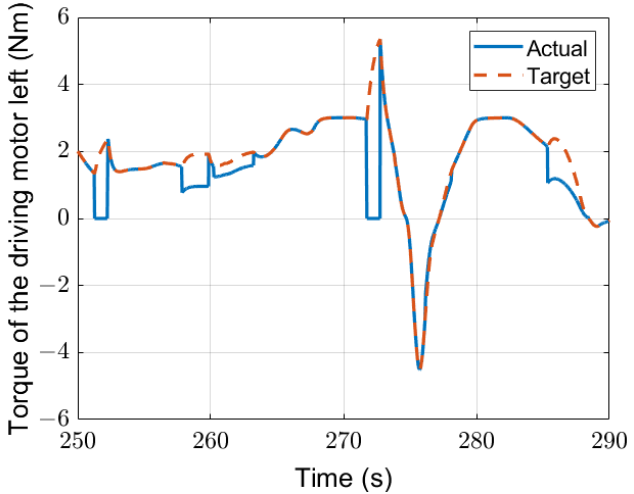
Figure 14. Torque of driving actuator left (Blue line: the actual steering torque with faults; red dotted line: the ideal driving torque with